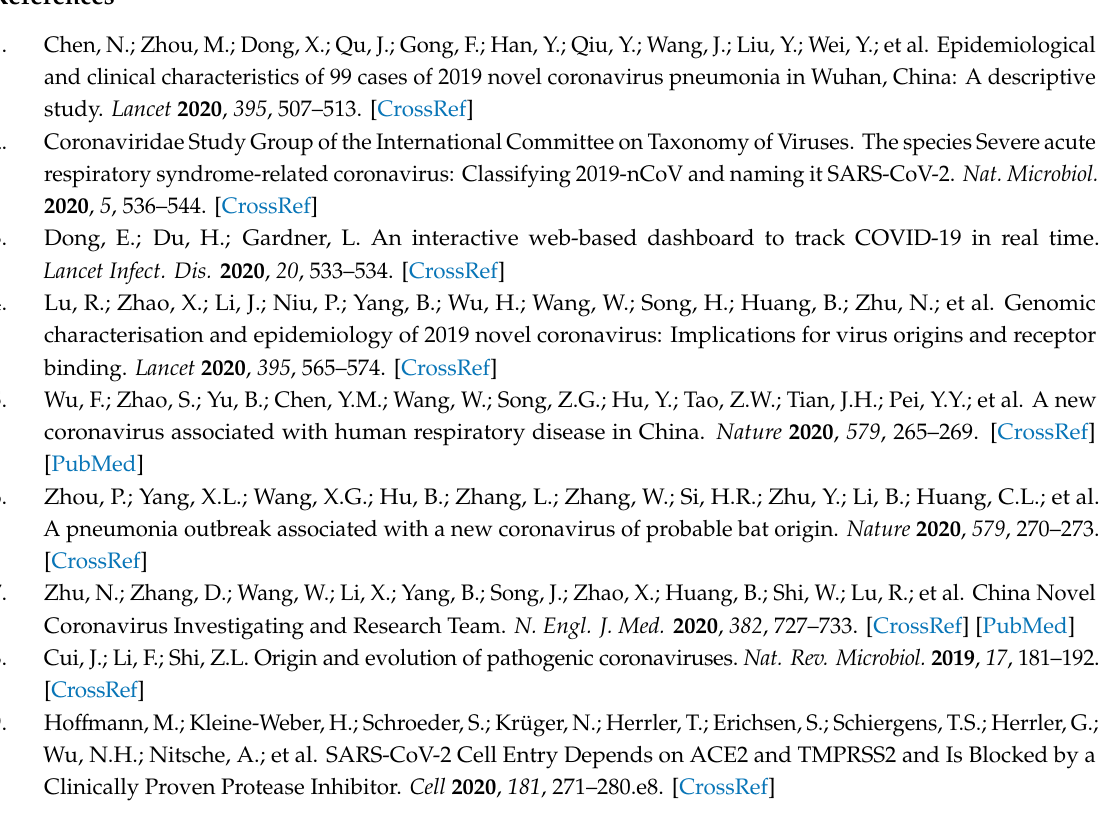
Figure S1: Quantification of immunostaining of SARS-CoV-2-infected Caco2 cells with and without treatment of aprotinin or SERPINA1 / alpha-1 antitrypsin; Figure S2: Trypsin inhibition by aprotinin and SERPINA1 / alpha-1 antitrypsin; Figure S3: Quantification of immunostaining for the spike protein in SARS-CoV-2-infected Calu-3 cells; Figure S4: Uncropped Western blots; Table S1: Detailed mass spectrometry